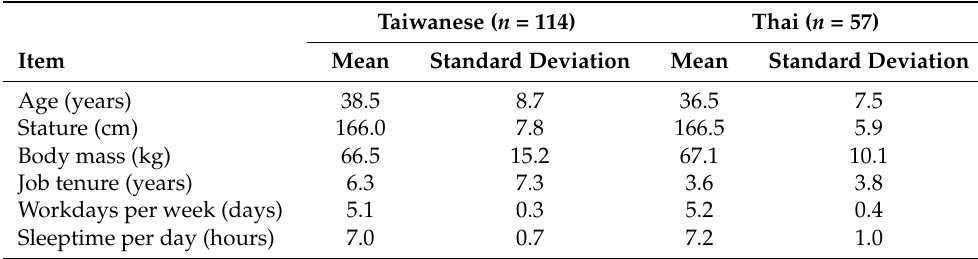
Table 1. Basic information of the 114 Taiwanese and 57 Thai workers.